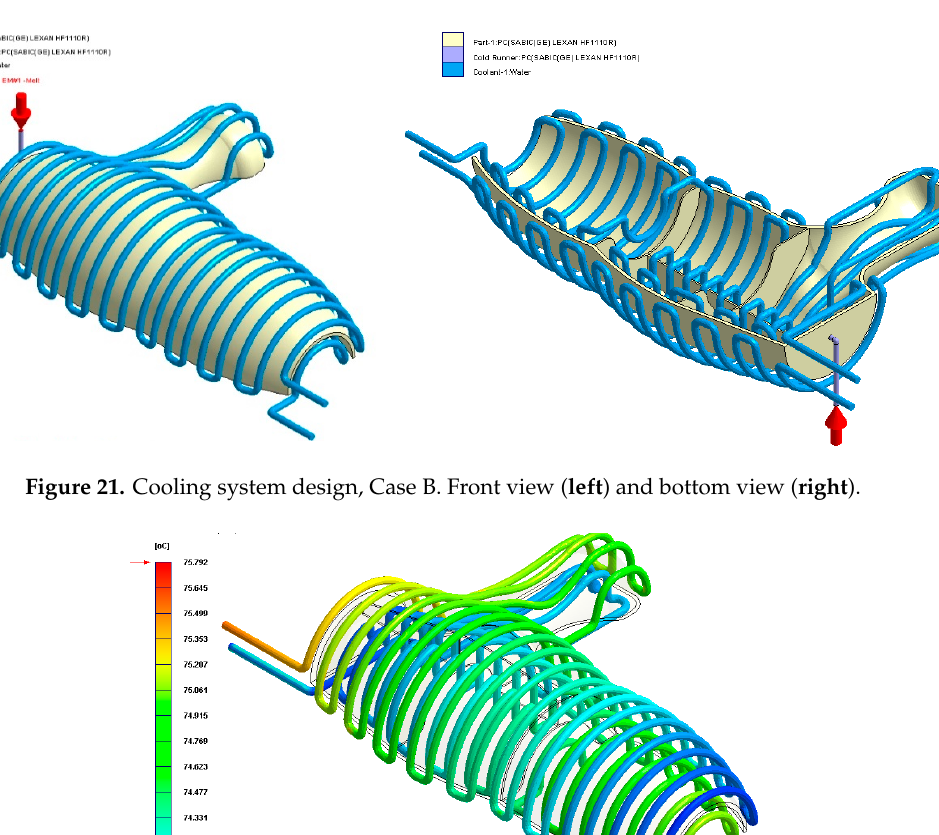
Figure 20. Plastic part, Case B.